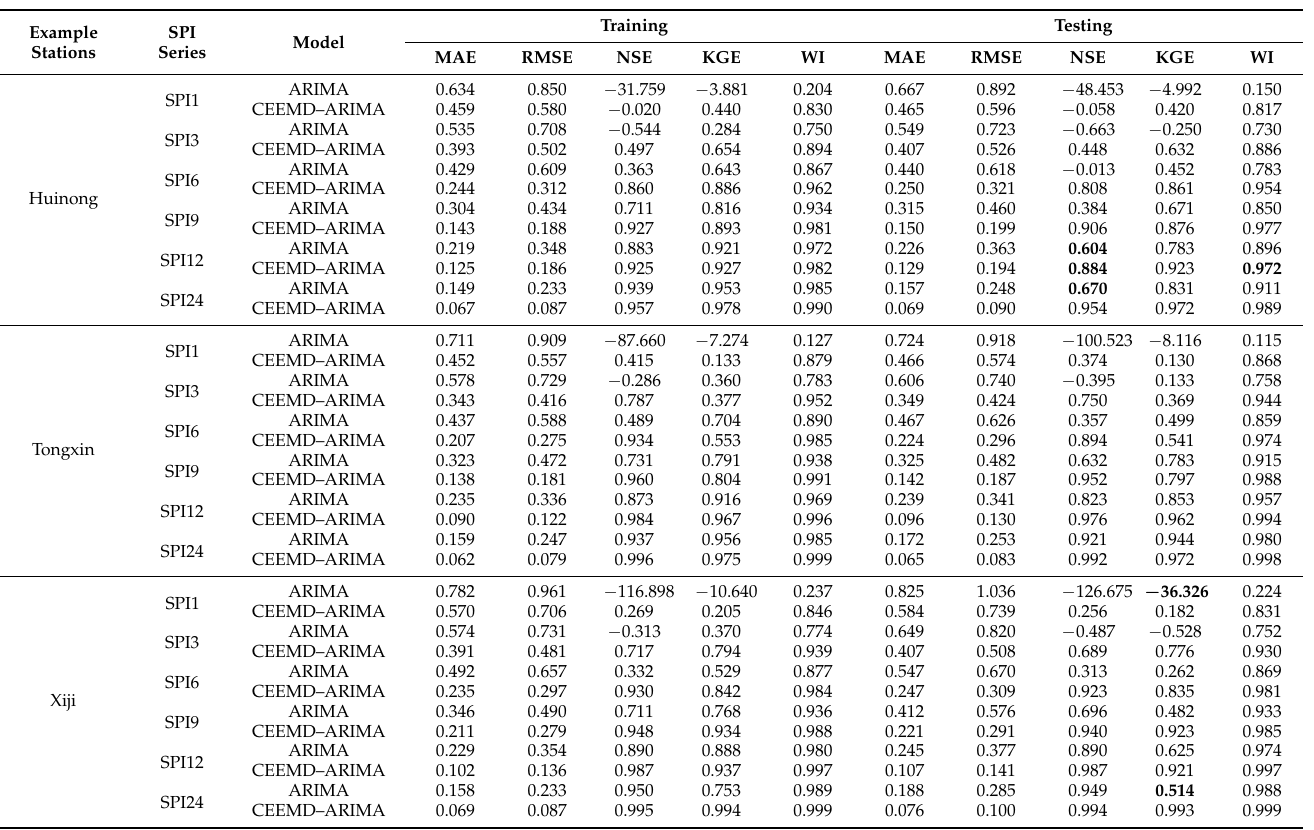
Table 6. The statistical criteria of the ARIMA and CEEMD–ARIMA